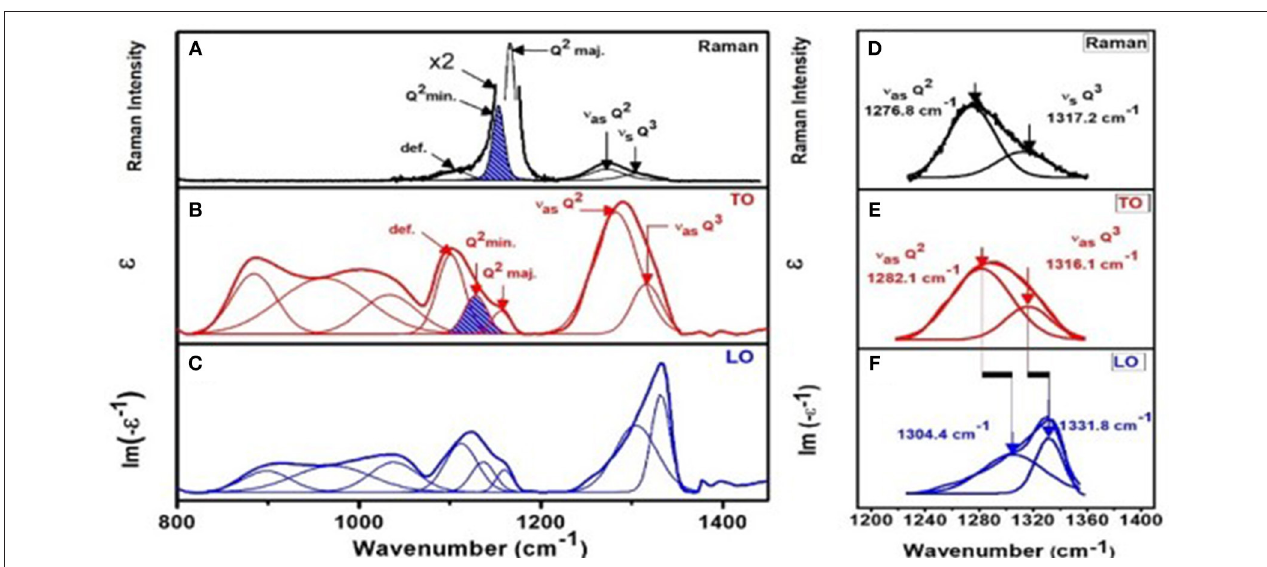
Frontiers in Materials |